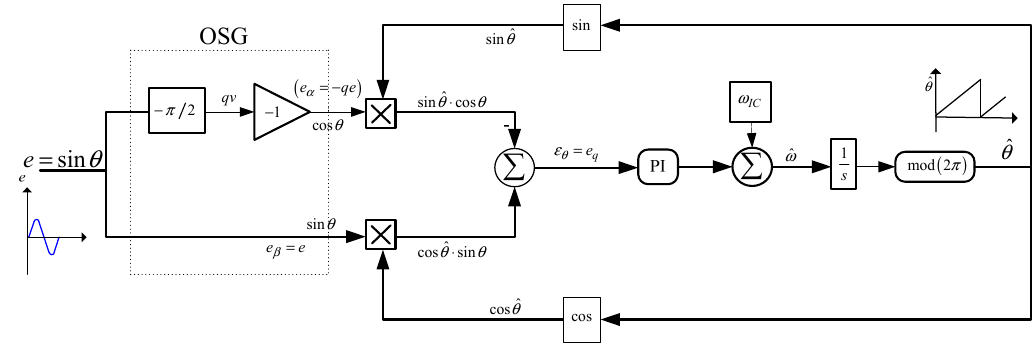
Figure 5. Detailed PLL structure based on the Park transform.